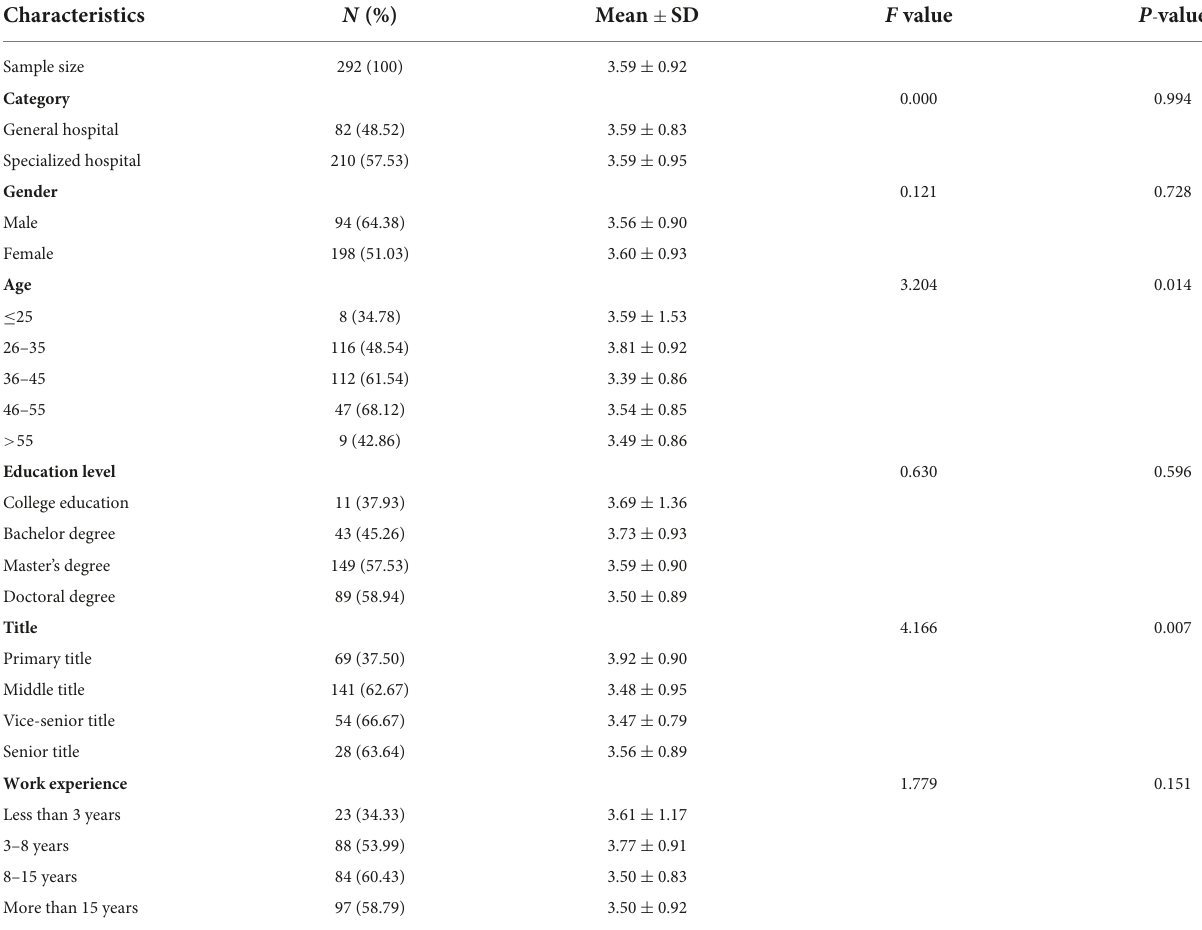
TABLE 4 Pediatricians’ satisfaction with internet hospitals ( N = 292).